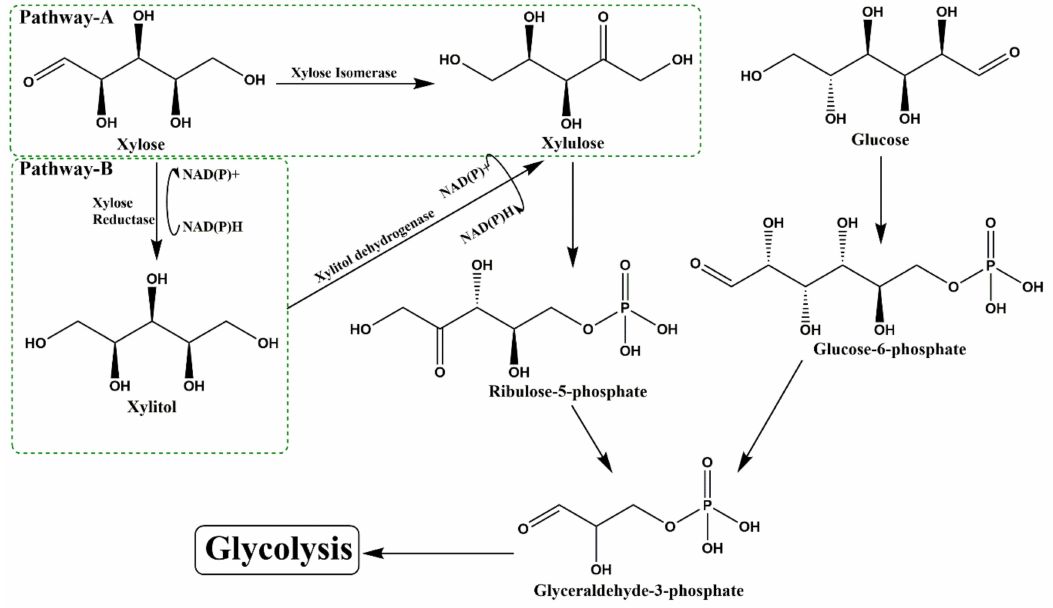
Figure 2. Xylose metabolism in ( A ) Xylitol non-producers and ( B ) Xylitol producer. Prokaryotes are able to oxidize xylose directly to xylulose in the presence of xylose isomerase (Pathway A) while in eukaryotes, this conversion proceeds with xylitol as an intermediate product (Pathway B). Pathway A: Among prokaryotes, intracellular xylose is directly transformed to xylulose by xylose isomerase (Enzyme commission Number; EC